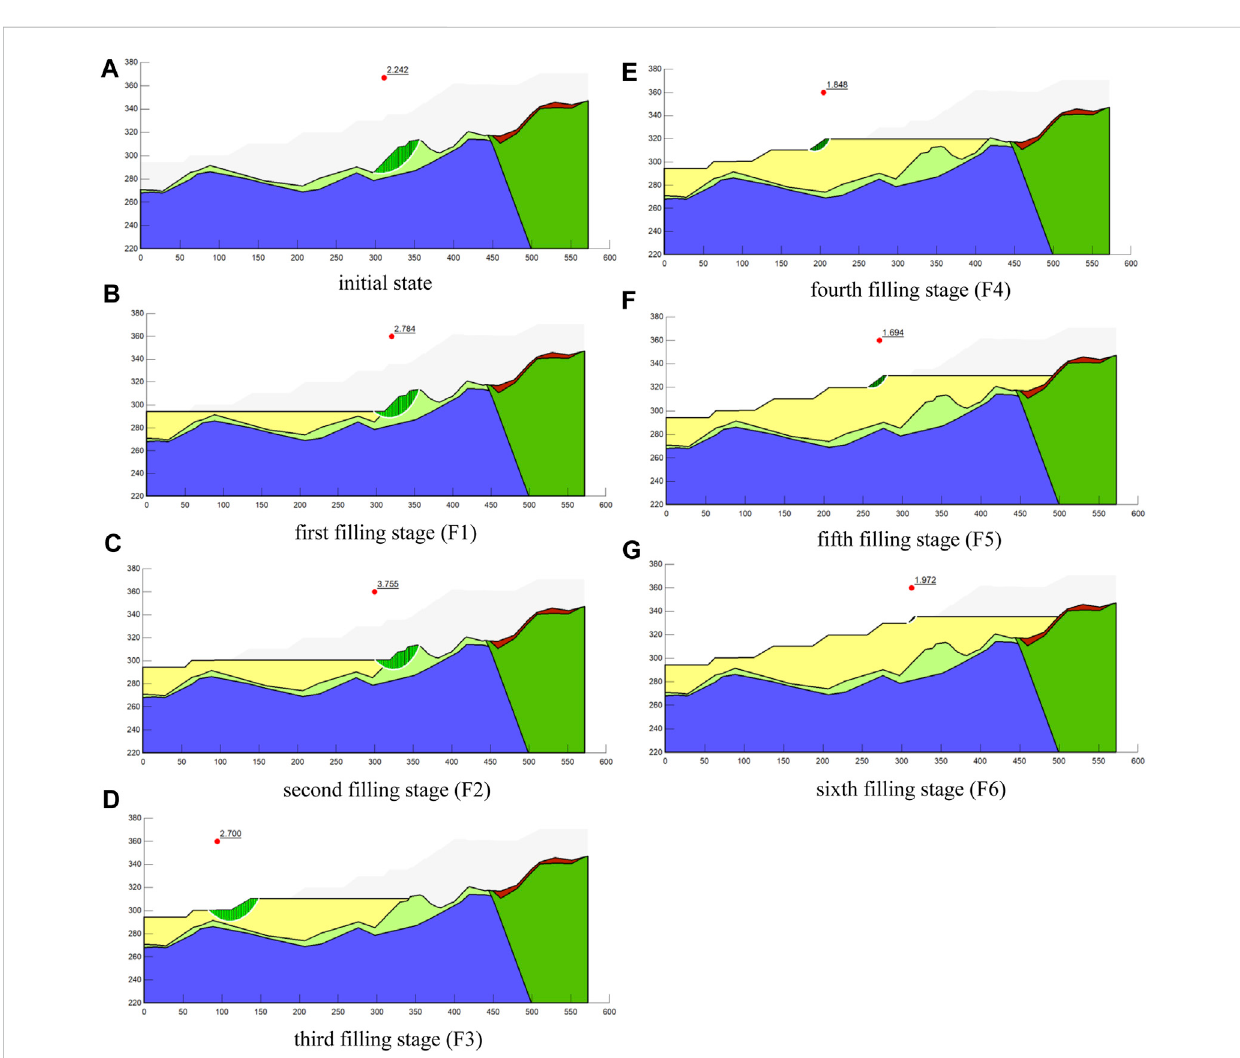
FIGURE 13 Potential sliding surfaces of thehigh- fi lled slope during theFarea fi lling process: (A) initial state; (B) fi rst fi llingstage (F1); (C) second fi lling stage (F2); (D) third fi lling stage (F3); (E) fourth fi lling stage (F4); (F) fi fth fi lling stage (F5); (G) sixth fi lling stage (F6).